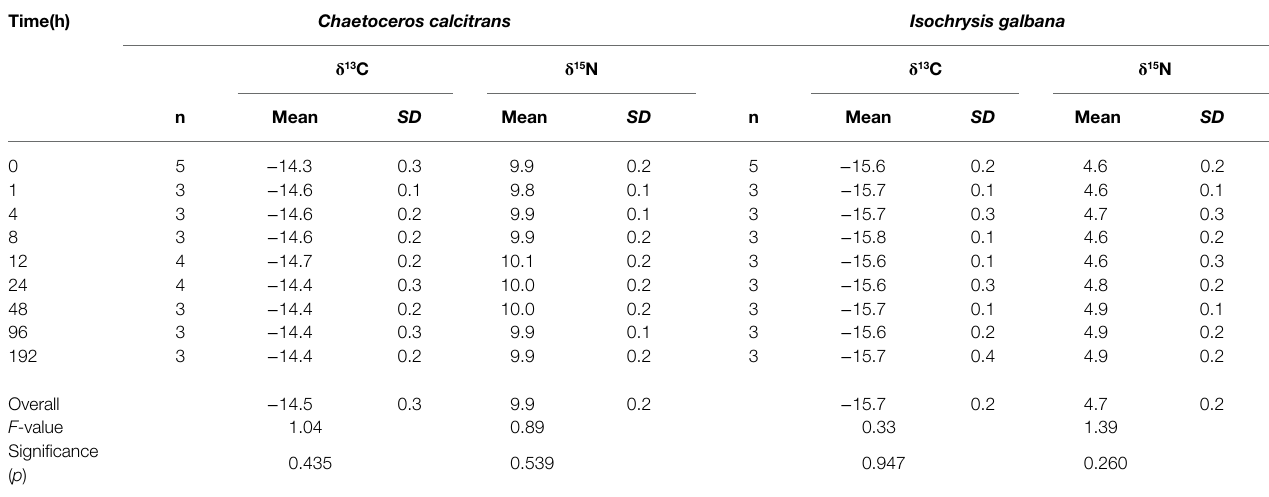
TABLE 1 | Mean δ 13 C and δ 15 N values of food sources ( Chaetoceros calcitrans and Isochrysis galbana ) for marine ciliates during the entire